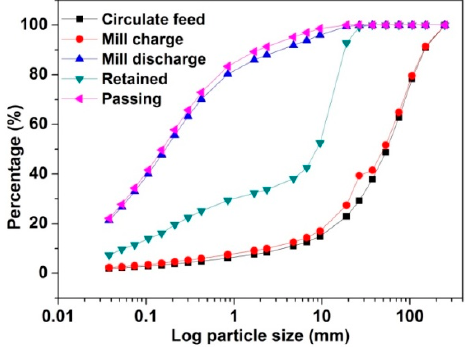
Figure 6. Particle size distribution of SAG-ball mill circuit.